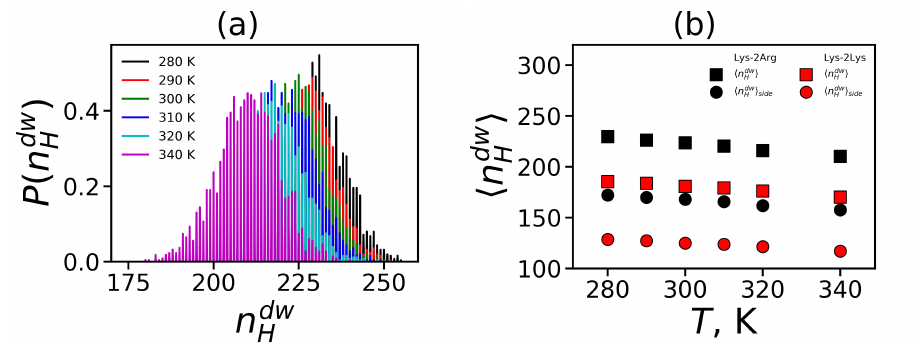
Figure 7. ( a ) The distribution of the dendrimer-water HB at different temperatures. ( b ) The average number of the dendrimer-water HB and the side segment-water HB as functions of temperature for the Lys-2Arg and Lys-2Lys